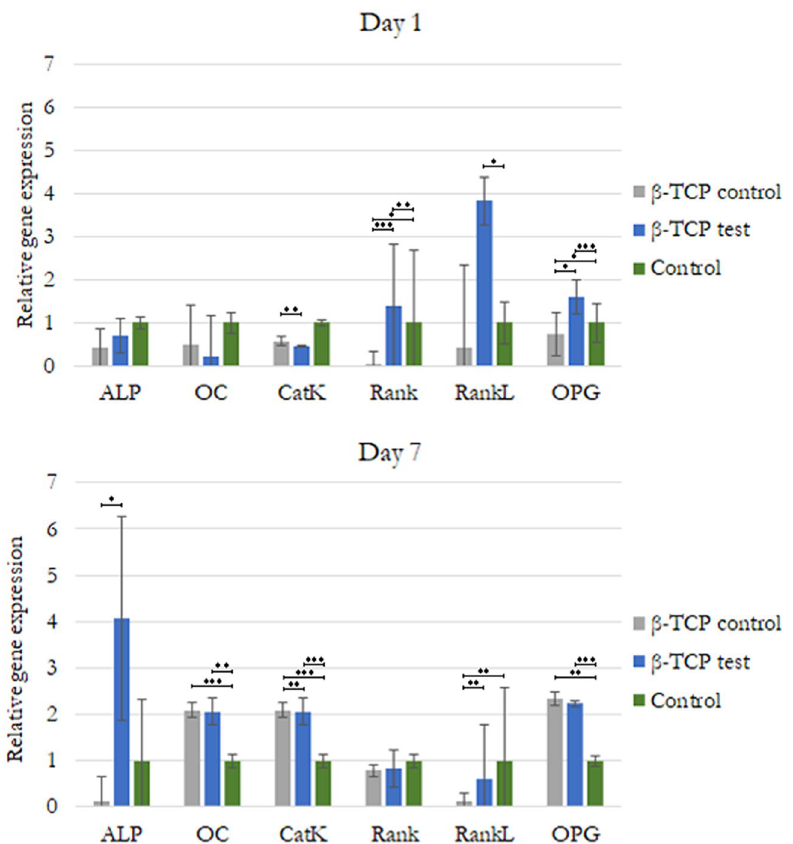
Figure 9. Relative gene expression of hMSCs indicating mainly osteogenic differentiation. Statistically significant difference indicated by * P < 0.05, ** P < 0.01, *** P <